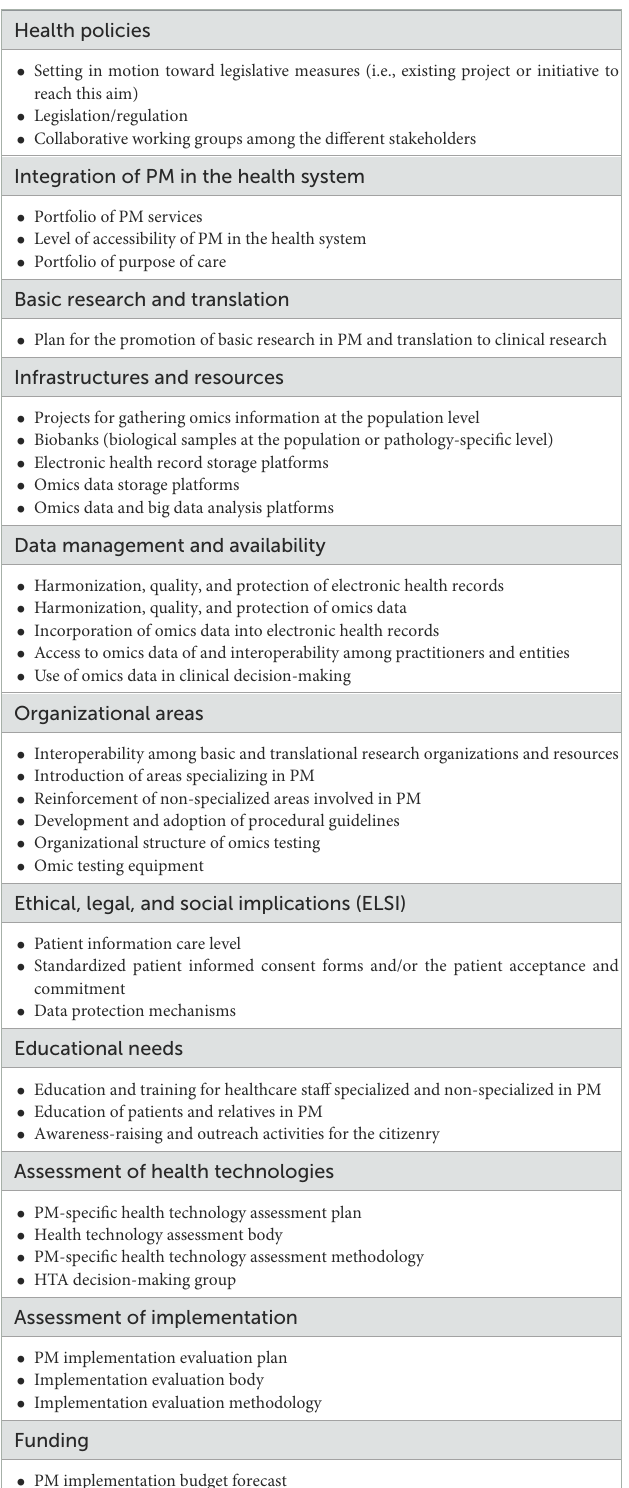
TABLE 1 Framework domains and elements for determining the level of PM